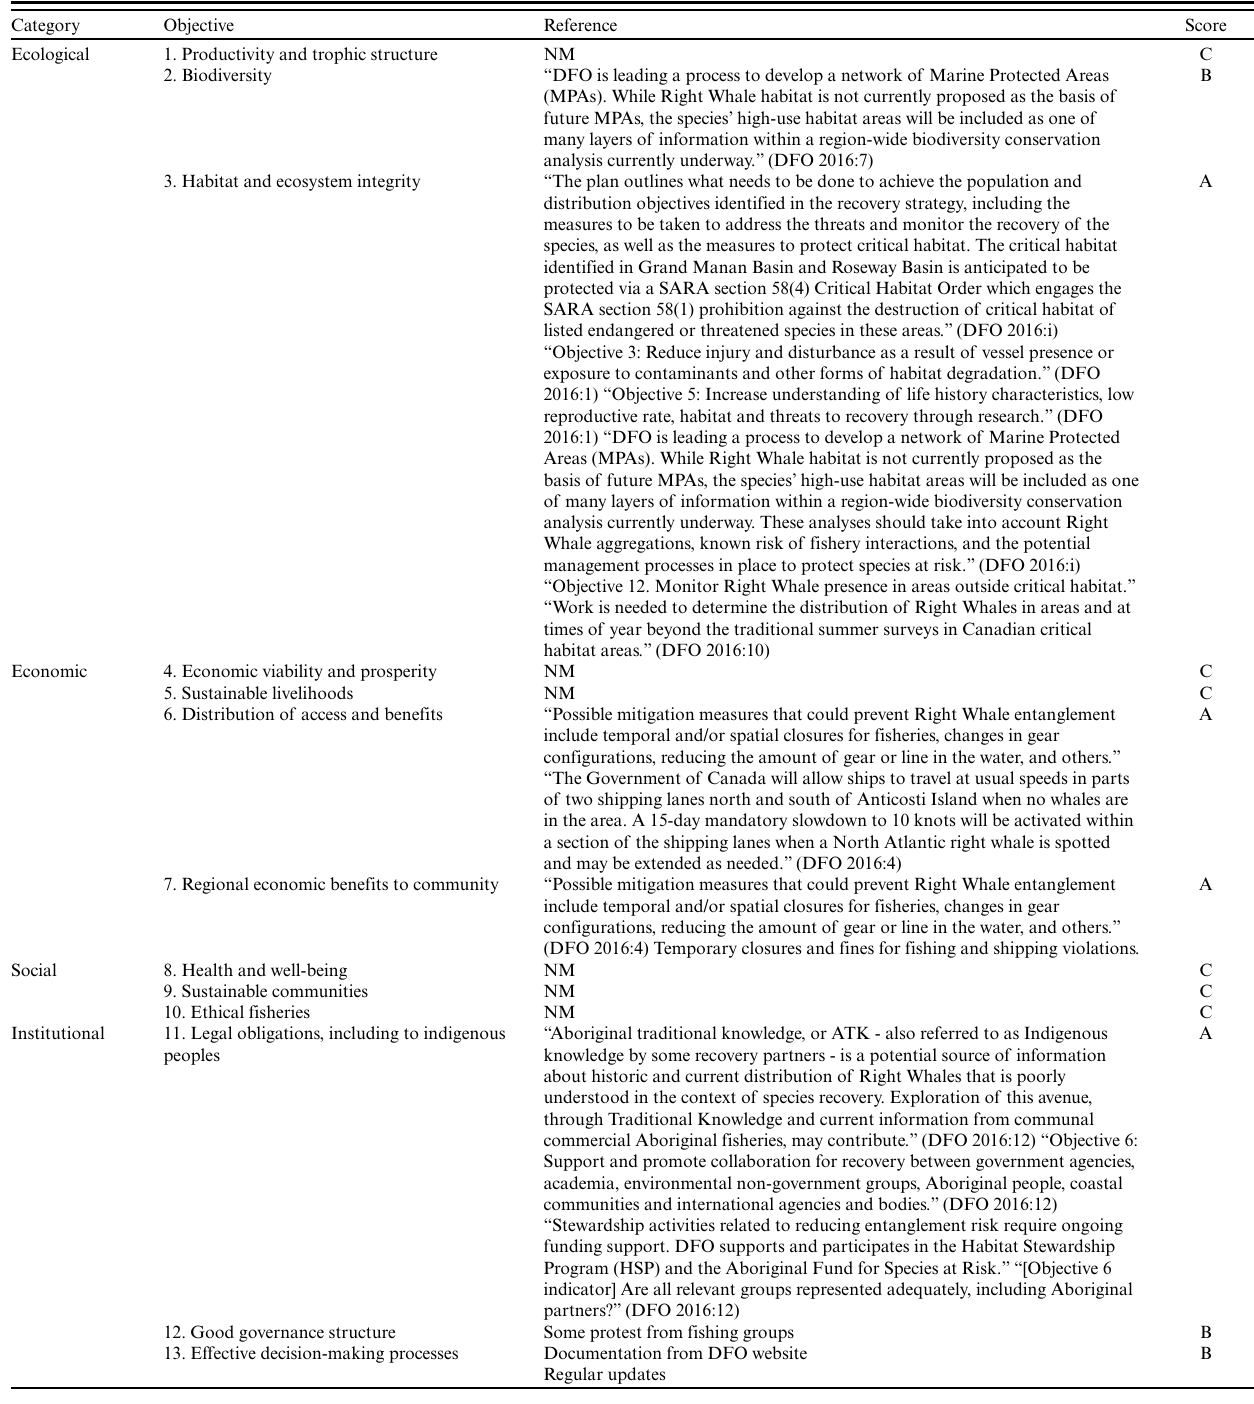
Table 6 . Desktop Canadian Fisheries Research Network evaluation of the 2016 Action Plan for the North Atlantic Right Whale (Department of Fisheries and Oceans [DFO] 2016). NM, no mention; SARA, Species at Risk Act.